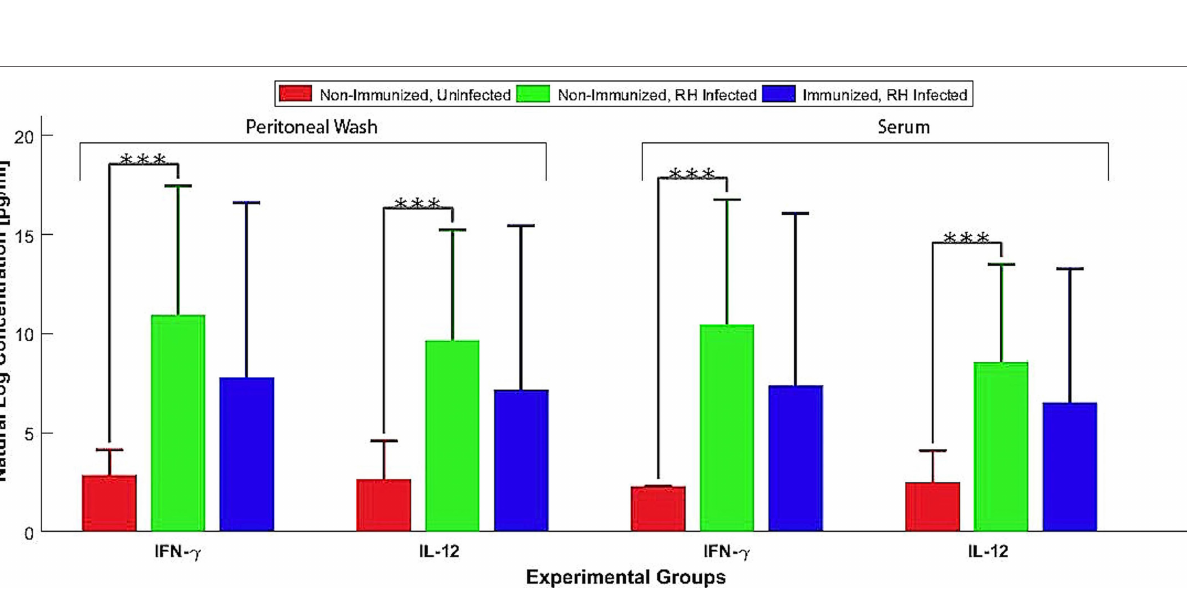
FigUre 6 | Protection of mice against acute lethal Toxoplasma gondii infection. Survival curves of Δ GRA17 -immunized mice, challenged intraperitoneally with 1 × 10 3 tachyzoites of RH, PYS, or TgC7 strain 70 days after immunization. The survival of mice was monitored for 35 days. A Log-rank (Mantel–Cox) test revealed that the difference in the survival rates between immunized and infected groups compared to non-immunized and infected groups as P = 0.003. All mice in the immunized groups remained alive at day 35 after infection, but all mice in the infected and non-immunized groups died between day 7 and 10 after infection. In addition to separate curves that show the difference in the survival rate between immunized and non-immunized mouse groups infected with RH, PYS, or TgC7 strain (a–c) , the overall survival rates in all immunized groups compared with the non-immunized positive control groups were combined in one graph (D)